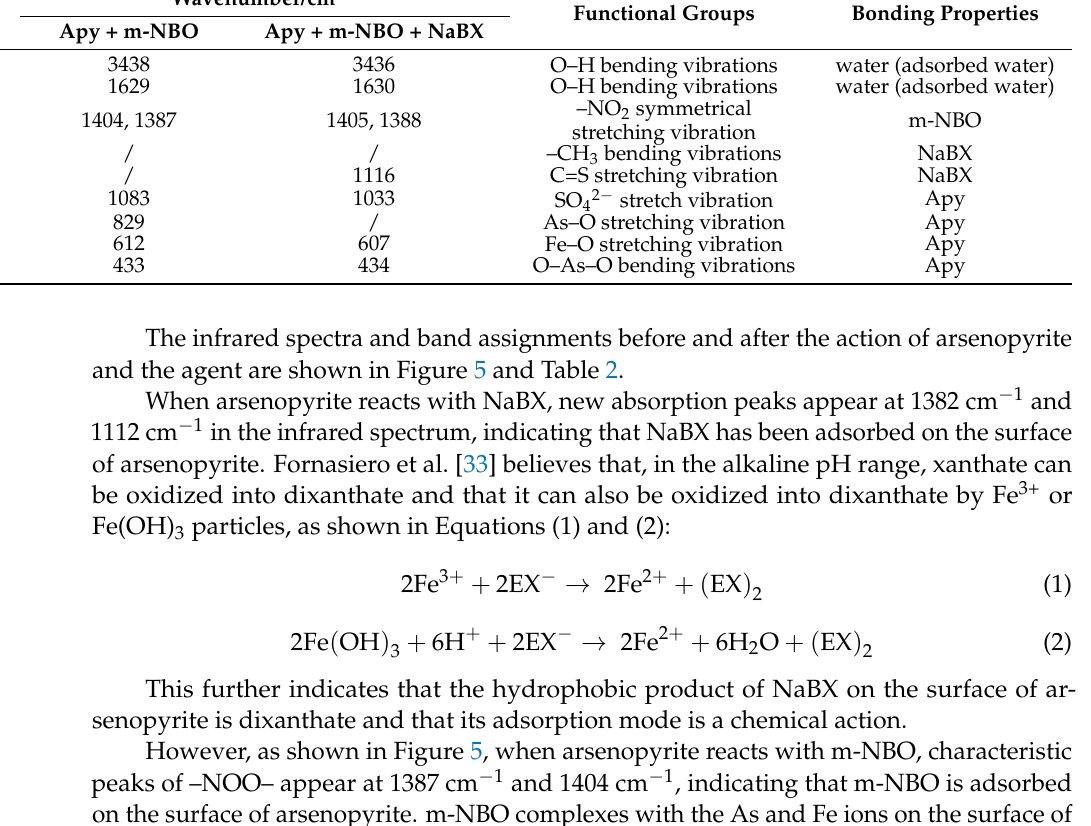
Table 2. Band assignments for arsenopyrite infrared spectrum features of m-NBO and NaBX (/ means none). Apy Apy + NaBX